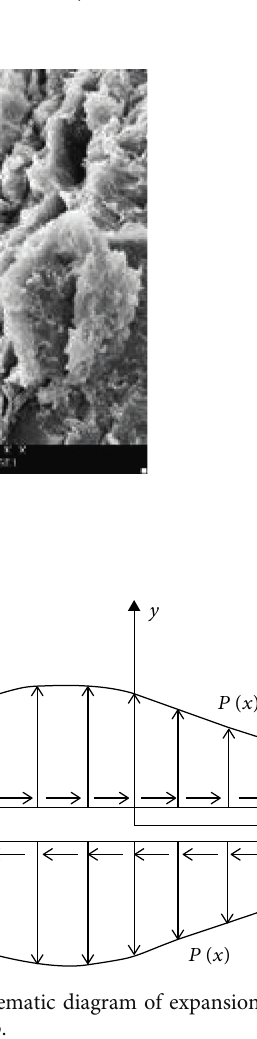
Figure 3: The results of XRD: (a) medium sandstone; (b) sandy sandstone.